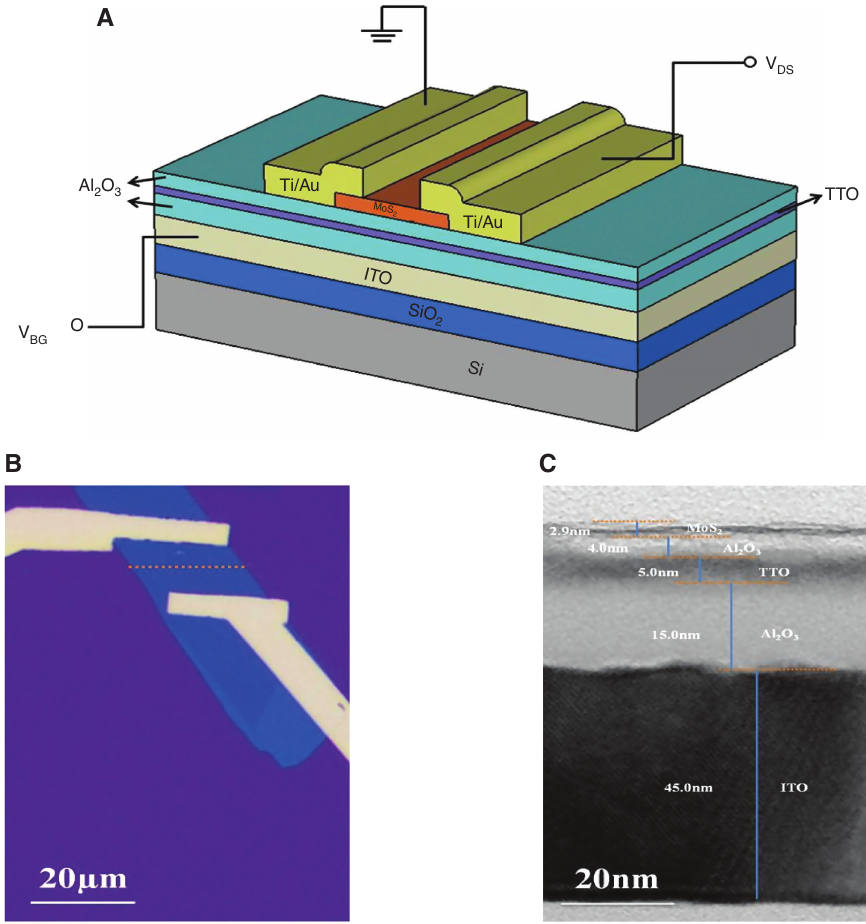
CTM device. 2 CTM device based on a back-gate FET structure. (B) Optical image of the MoS flake on surface of the 2 2 O , 5-nm TTO, 4-nm Al O , and 2.9-nm MoS . The image was obtained along the cut line 2 3 2 3 2